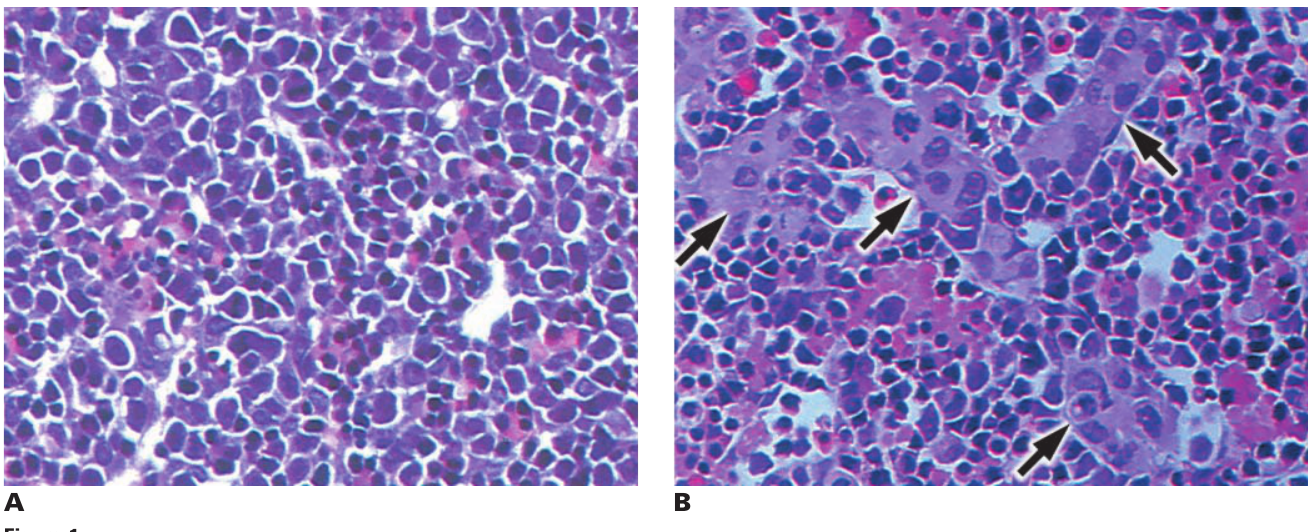
Figure 2 Schematic view of human MTF-1 protein (top). Overview of known and inferred activation pathways and downstream func- tions of the metal transcription factor MTF-1 (below). See text for details.